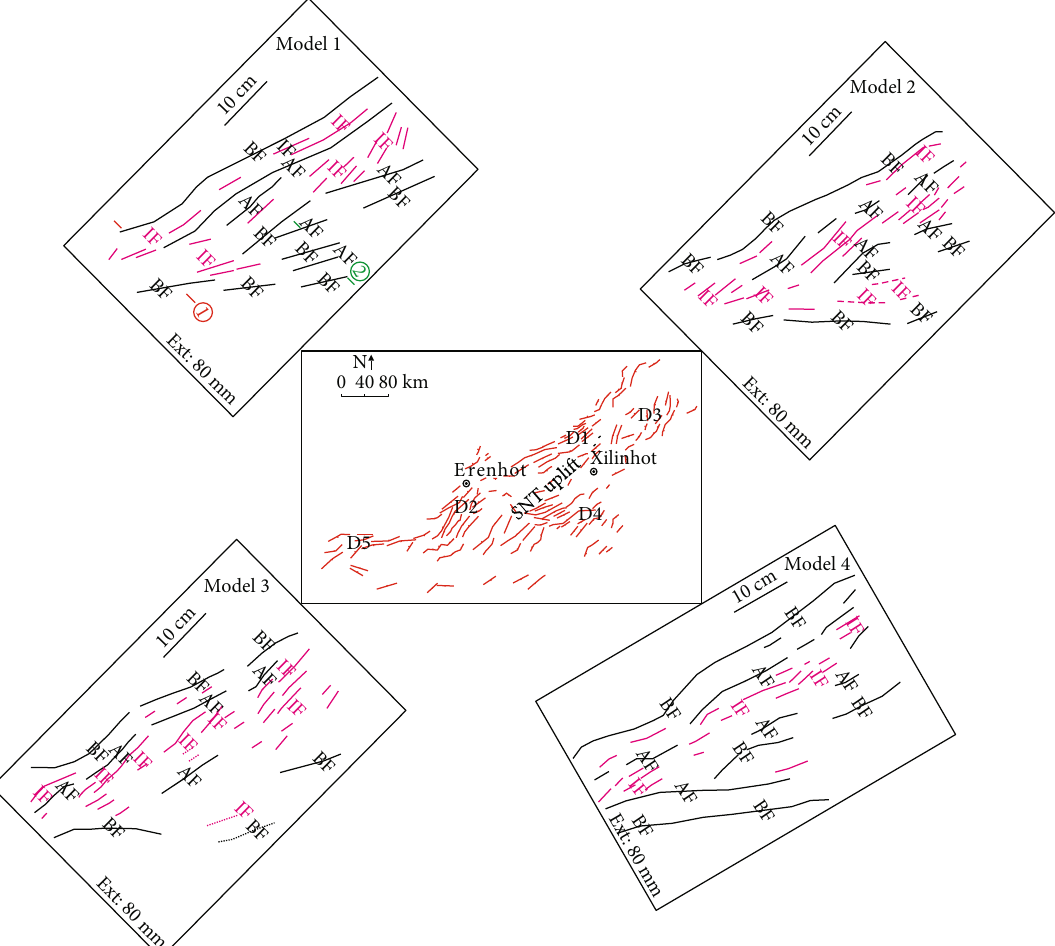
Figure 13: Comparison between experimental models and the actual geologic structure of Erlian